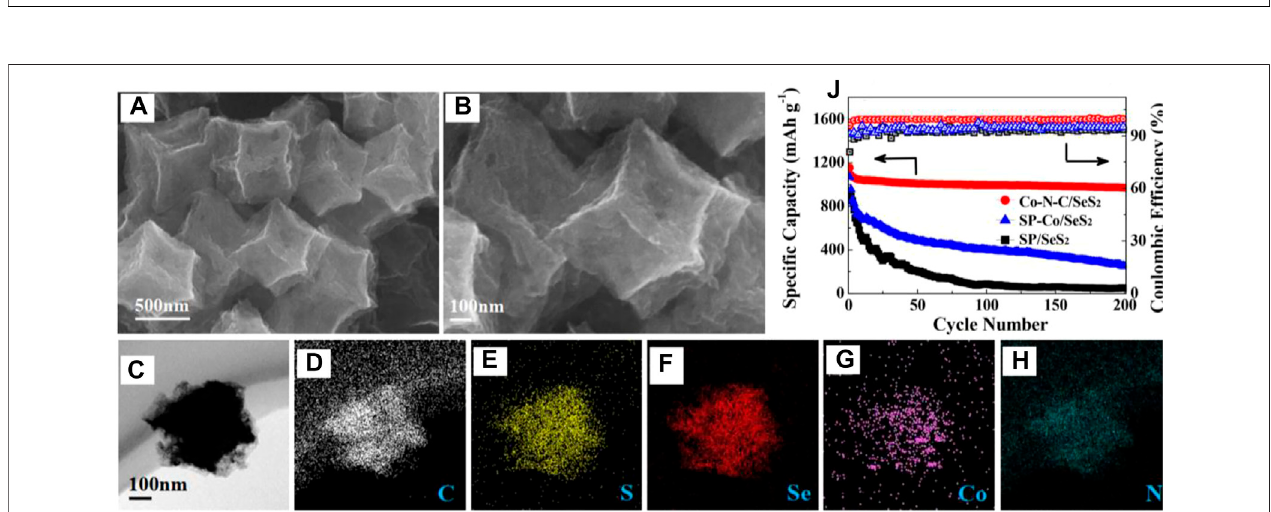
FIGURE 6 | SEM images of (A) Co-N-C and (B) Co-N-C/SeS 2 composites. The TEM image of a single Co-N-C/SeS2 polyhedron (C) and the corresponding elemental mapping images of (D) C (E) S (F) Se (G) Co, and (H) N (J) Cyclic stability of the SP/SeS 2 , SP-Co/SeS 2, and Co-N-C/SeS 2 cathodes at 0.2 C for 200 cycles. Reproduced with permissions from the ref (He et al., 2018). Copyright © 2018 the Royal Society of Chemistry.